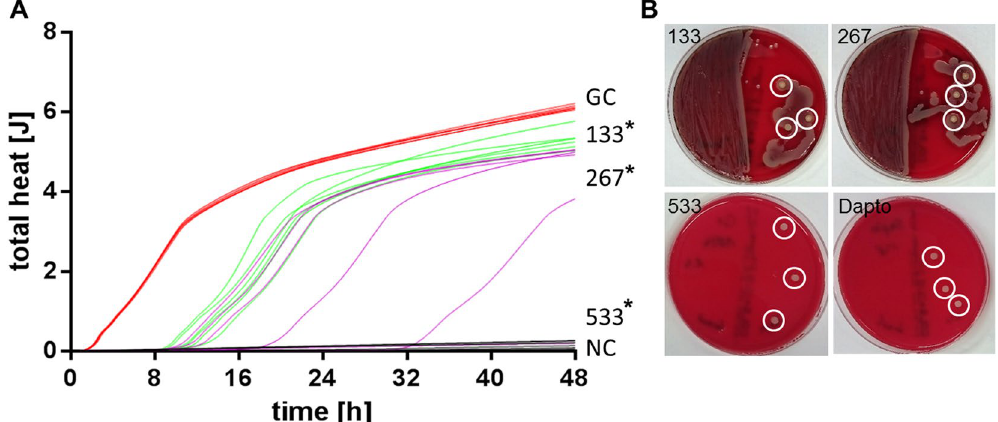
Figure 7. S.aureus biofilm was grown on glass beads and incubated with 133–533 µ g/ml AMP2 and heat flow of the bacteria was measured over 48 hours. (A) Total heat over time. red: growth control (GC), gray: negative control (NC) - beads without bacteria, green: 133 µ g/ml AMP2, purple: 267 µ g/ml AMP2, black: 533 µ g/ml µ g/ ml AMP2 (n = 6). Kruskal-Wallis, Mann-Whitney, Bonferroni-Holm post-hoc test: * Significant compared to growth control, p ≤ 0.05. (B) After calorimetry measurement, samples and glass beads were plated on one half of a CA plate, respectively. Shown are exemplarily plates with medium sample on the left and three glas beads (circles) of 133, 267, 533 µ g/ml AMP2 and 128 µ g/ml daptomycin on the right side.